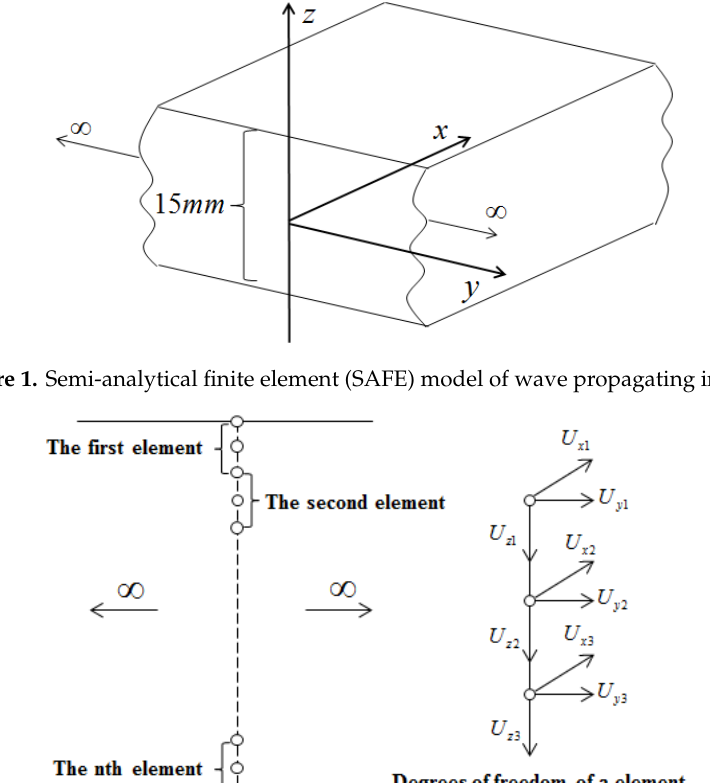
Table 1. Material properties of the